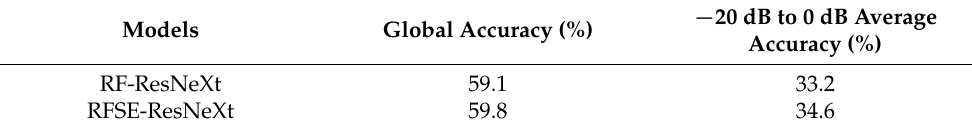
Table 1. Effect of adding a squeeze–excitation structure on the